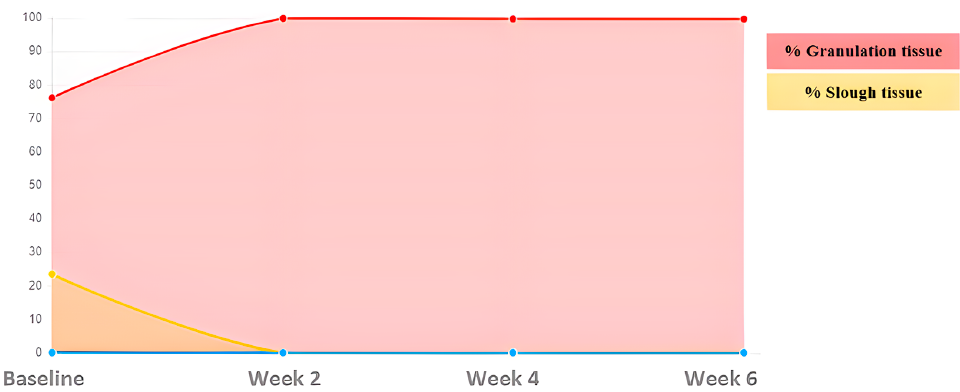
Figure 10 . Evolution of tissue types. Case 5.